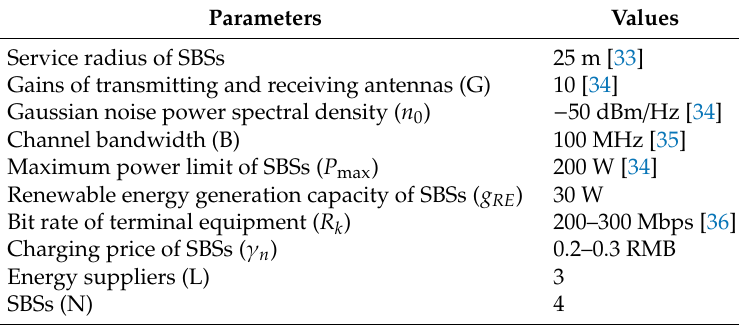
Table 1. Simulation parameters.